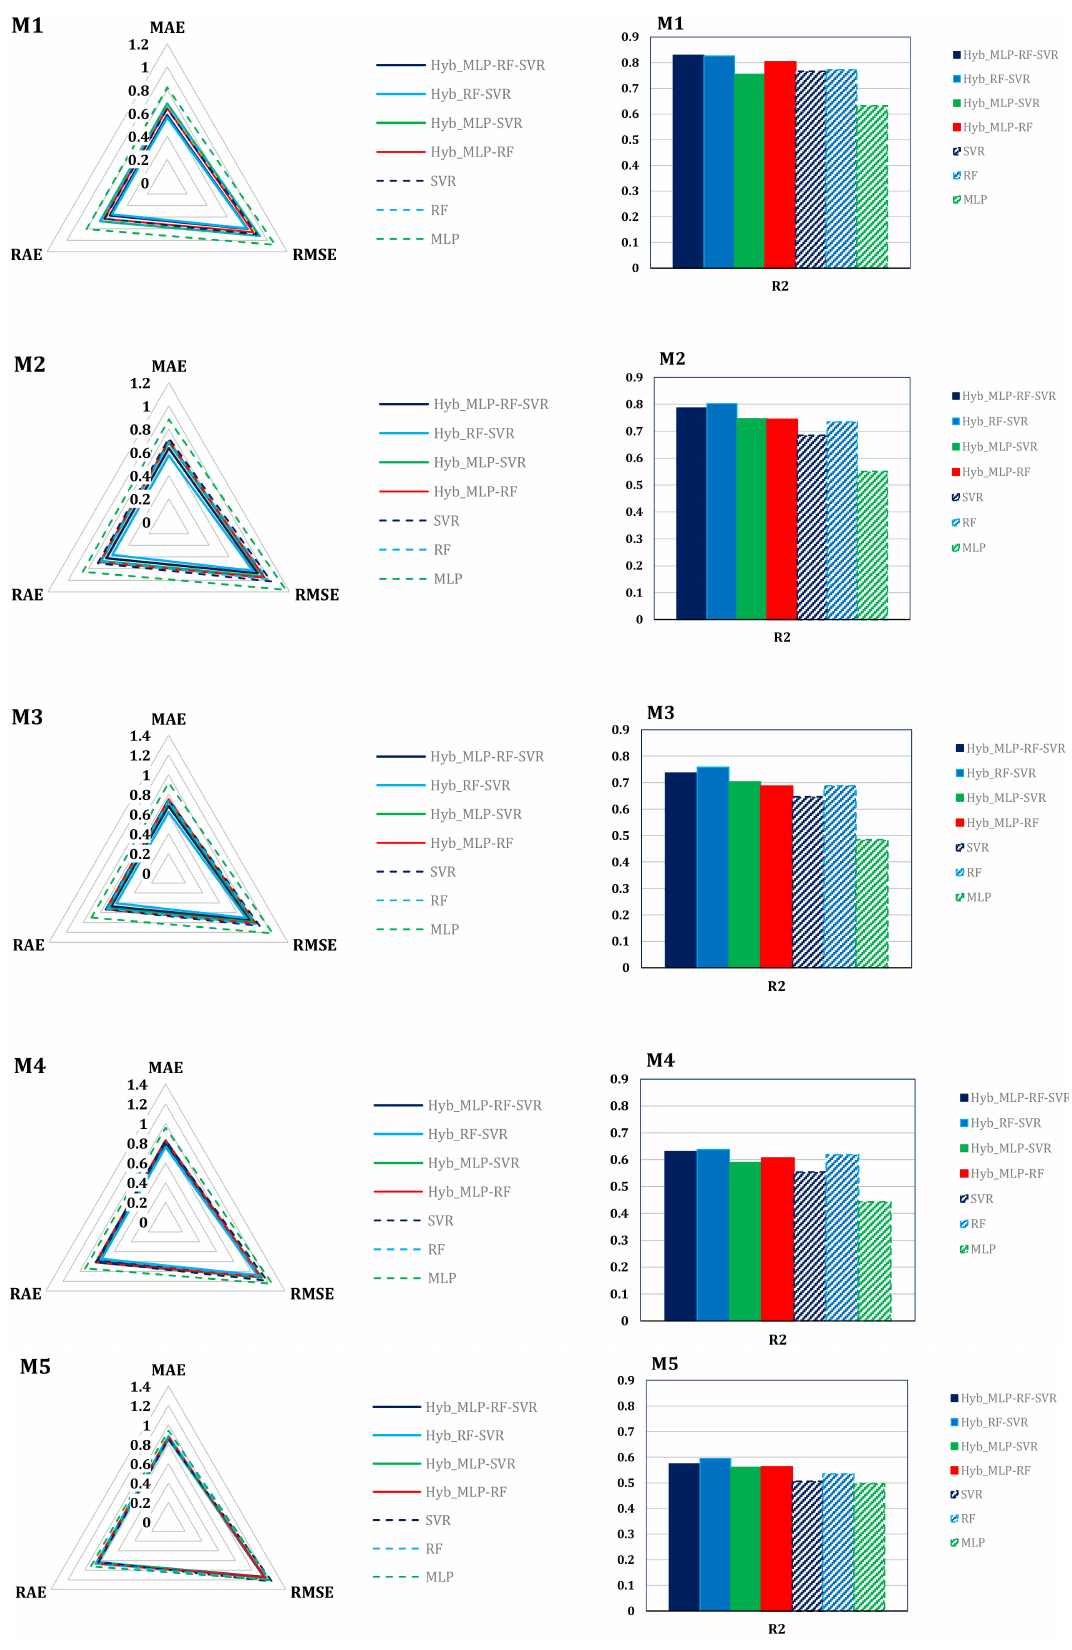
Figure 6. Radar charts of the error metrics ( left column ) and histograms of the coefficients of determination ( right column